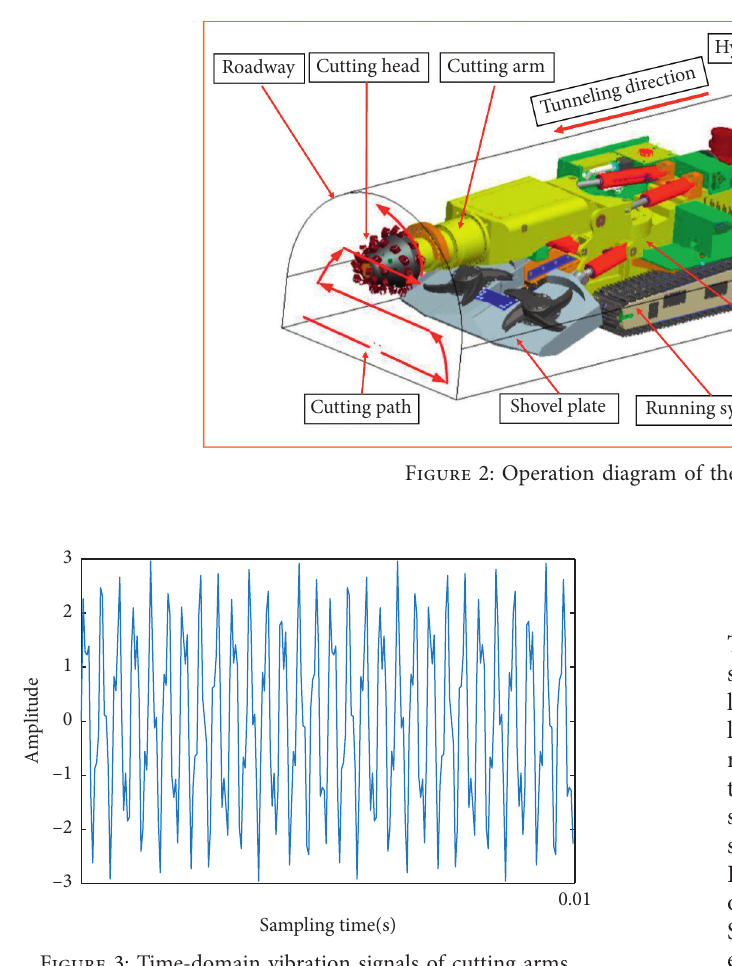
Figure 3: Time-domain vibration signals of cutting arms.